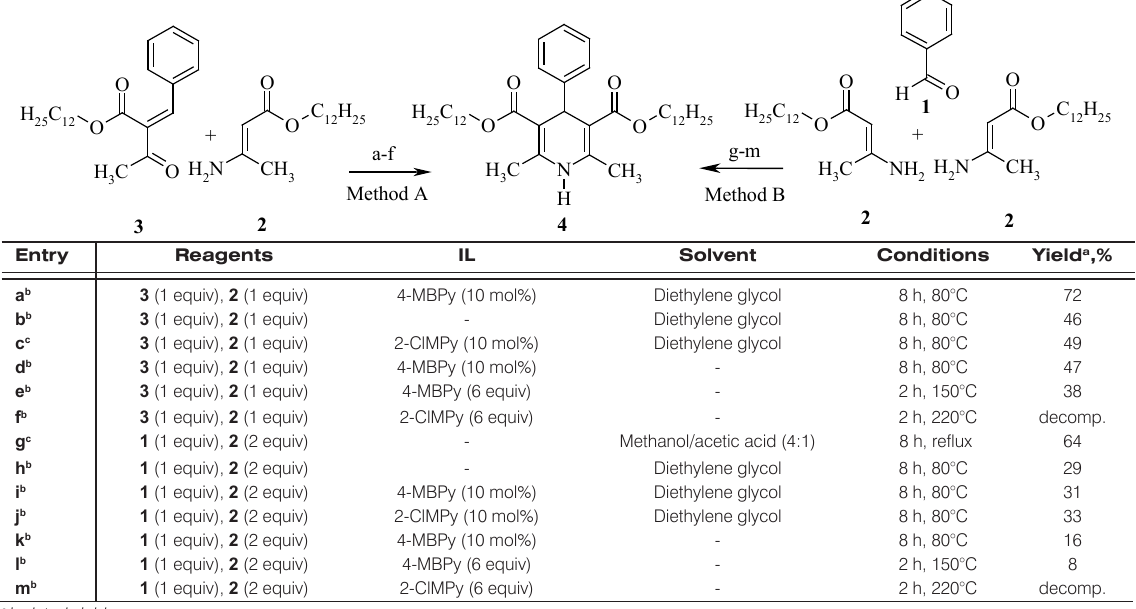
Table 1. Two synthetic approaches for the preparation of 1,4-DHP 4